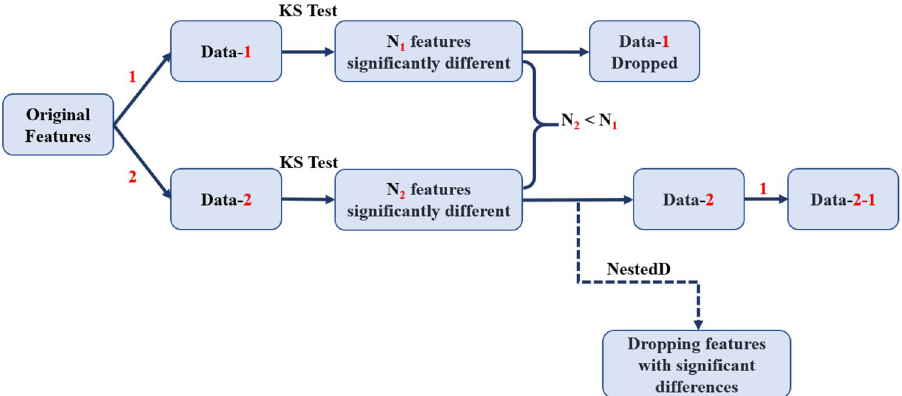
Figure 5. Workflow for the Nested ComBat implementation for sequential harmonization given two batch effects. Red denotes a batch effect, while the dash indicates that the data has been harmonized by a particular batch effect (i.e., Data-1 means the data has been harmonized by batch effect